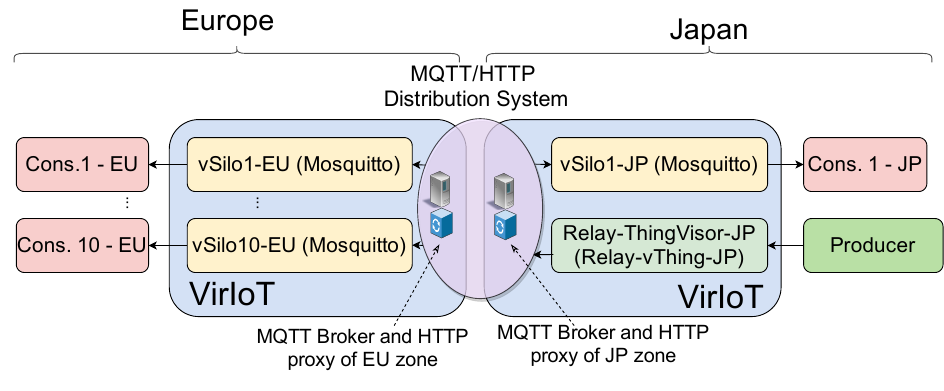
Figure 9. Test scenario